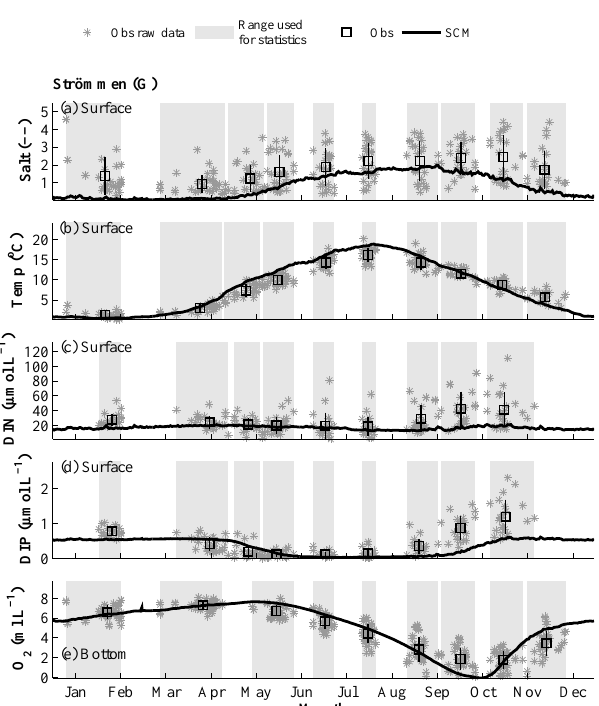
Figure 8. Simulated (lines) and observed averages (squares) of the seasonal variation and the standard deviation (vertical lines) of the observations in the basin Strömmen (1990–2012) of surface tem- perature (Temp), salinity, DIN and DIP and of the bottom water oxygen concentrations. Time periods with dense number of obser- vations (grey asterisks) determined the time intervals (grey shaded area) used in the calculations.